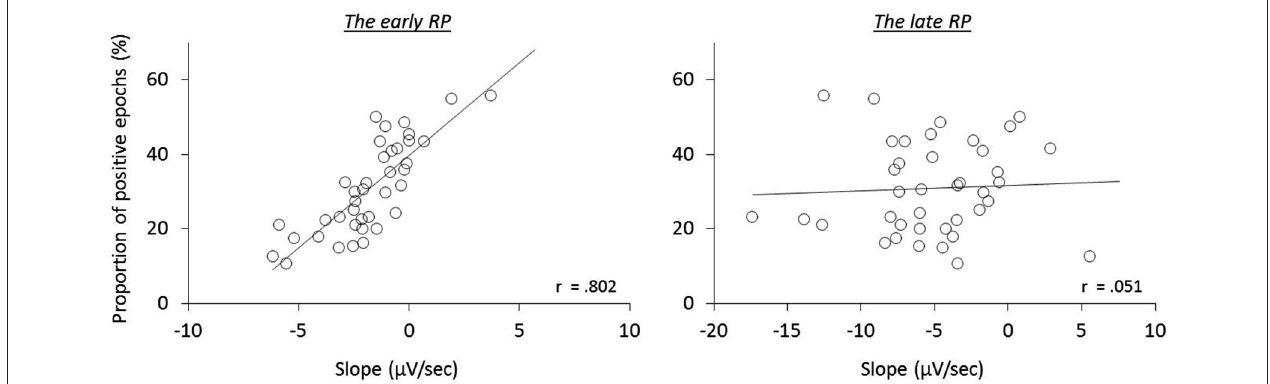
FIGURE 5 | The relation of the proportion of ongoing positive epochs to the RP slopes during the operant-T task